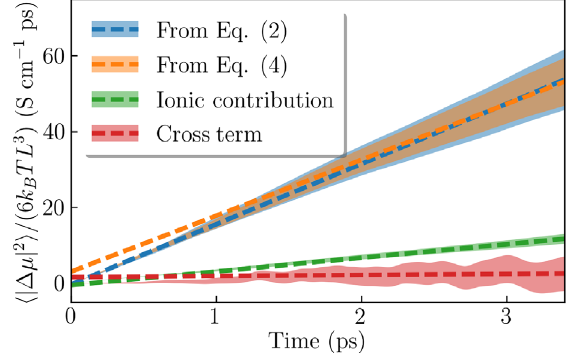
= ð KCl Þ 0 . 94 . . 06